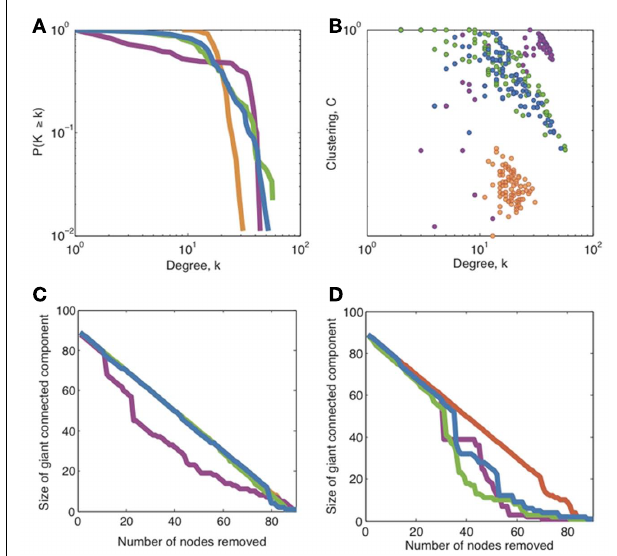
FIGURE 5 |A comparison of topological properties of networks at the particular connection density approximately maximizing cost-efficiency (20%). These plots show a comparison of (A) the degree distribution, (B) hierarchy, and (C,D) robustness to random and targeted attacks respectively, for the financial network (green), brain functional network (blue), political network (magenta), and the Black–Scholes model network (orange). Note that for random attacks (C) , the curves for financial networks, Black–Scholes models, and brain networks overlap almost exactly.The cost of each network is set to 0.21, which corresponds to the cost which maximizes cost-efficiency in the brain functional network.